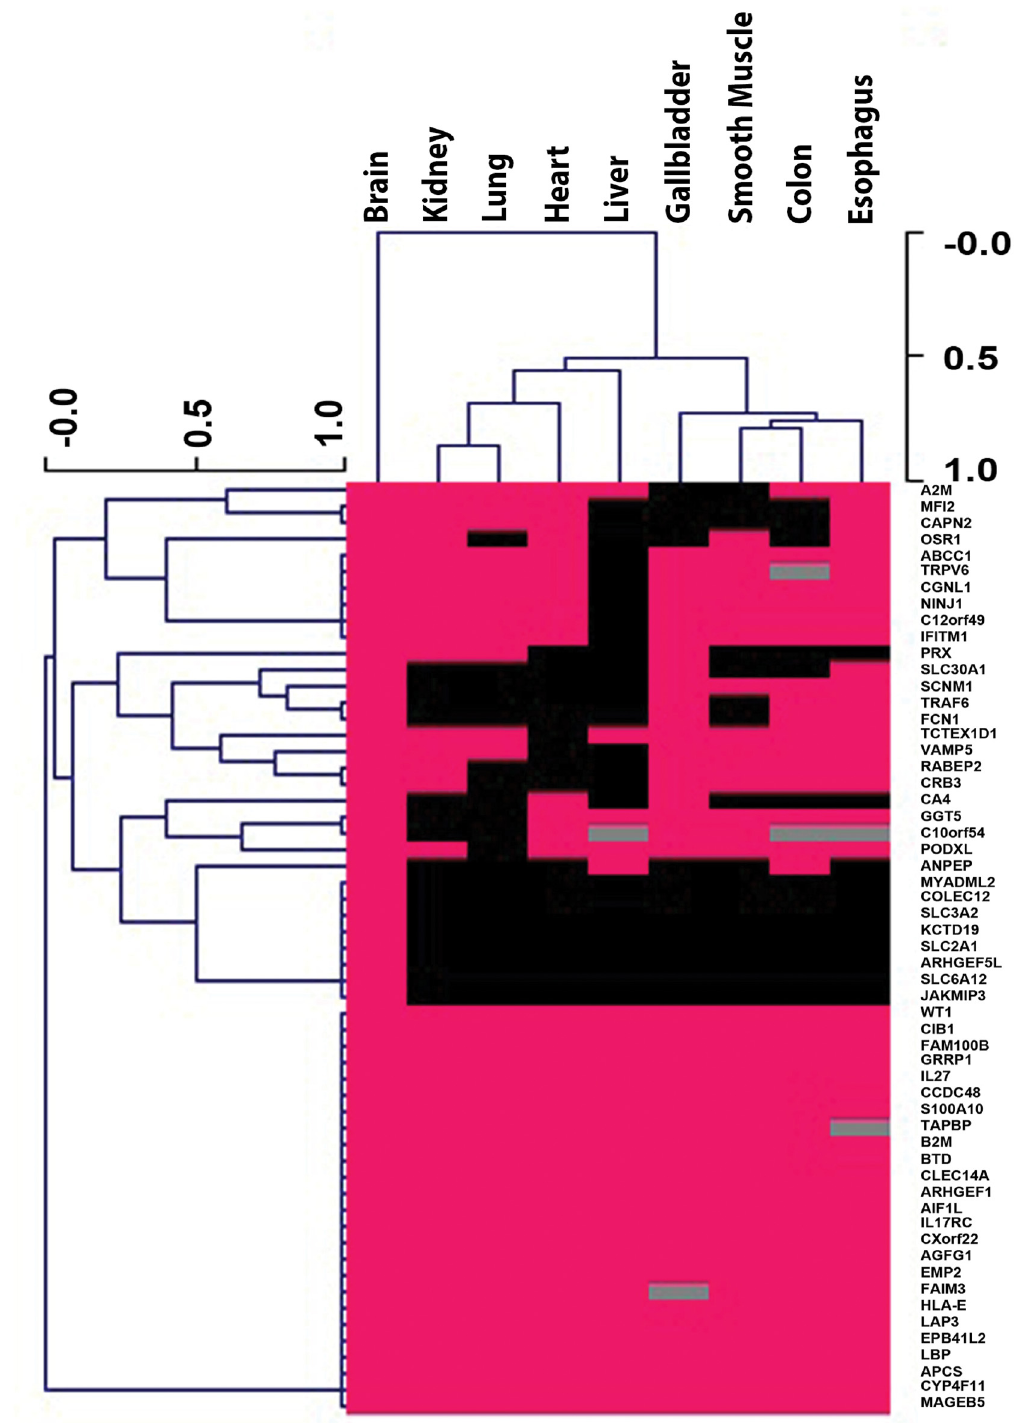
Fig 3. Cluster analysis of brain endothelial proteins identified by Human Protein Atlas analysis. Proteins with expressionin cerebralendothelialcells (without smooth muscle expressionin any tissue; a subset selectedfrom Table 1) were scored for non-cerebral EC expressionin tissues shown. Expression in these tissues was given a binary score (yes [pink] or no [black]) and cluster analysiswas performed to identify patterns of tissue expression using the MeV availableonline(mev.tm4.org) to displayhierarchical clustering of tissue distributions (on the x-axis) and clusters of proteins in similar distributions(on the y-axis). Some expressiondata was not available from the Human Protein Atlas (grey